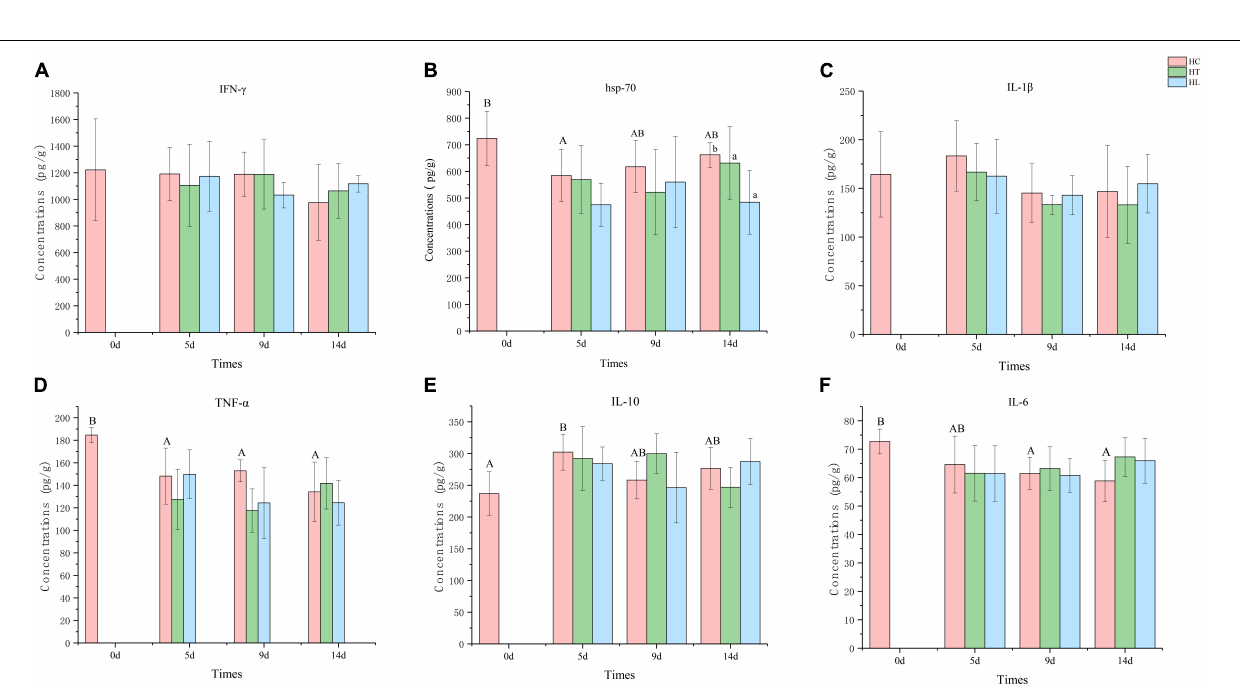
FIGURE 4 | The concentration of different immune-related cytokines in different intestinal samples. (A) IFN- γ , (B) HSP-70, (C) IL-1 β , (D) TNF- α , (E) IL-10, and (F) IL-6. Values are given as the mean ± SD ( n = 10–12). HC: The control group, HT: The L. lactis 1,209 treatment group, HL: The L. lactis 1,242 treatment group.